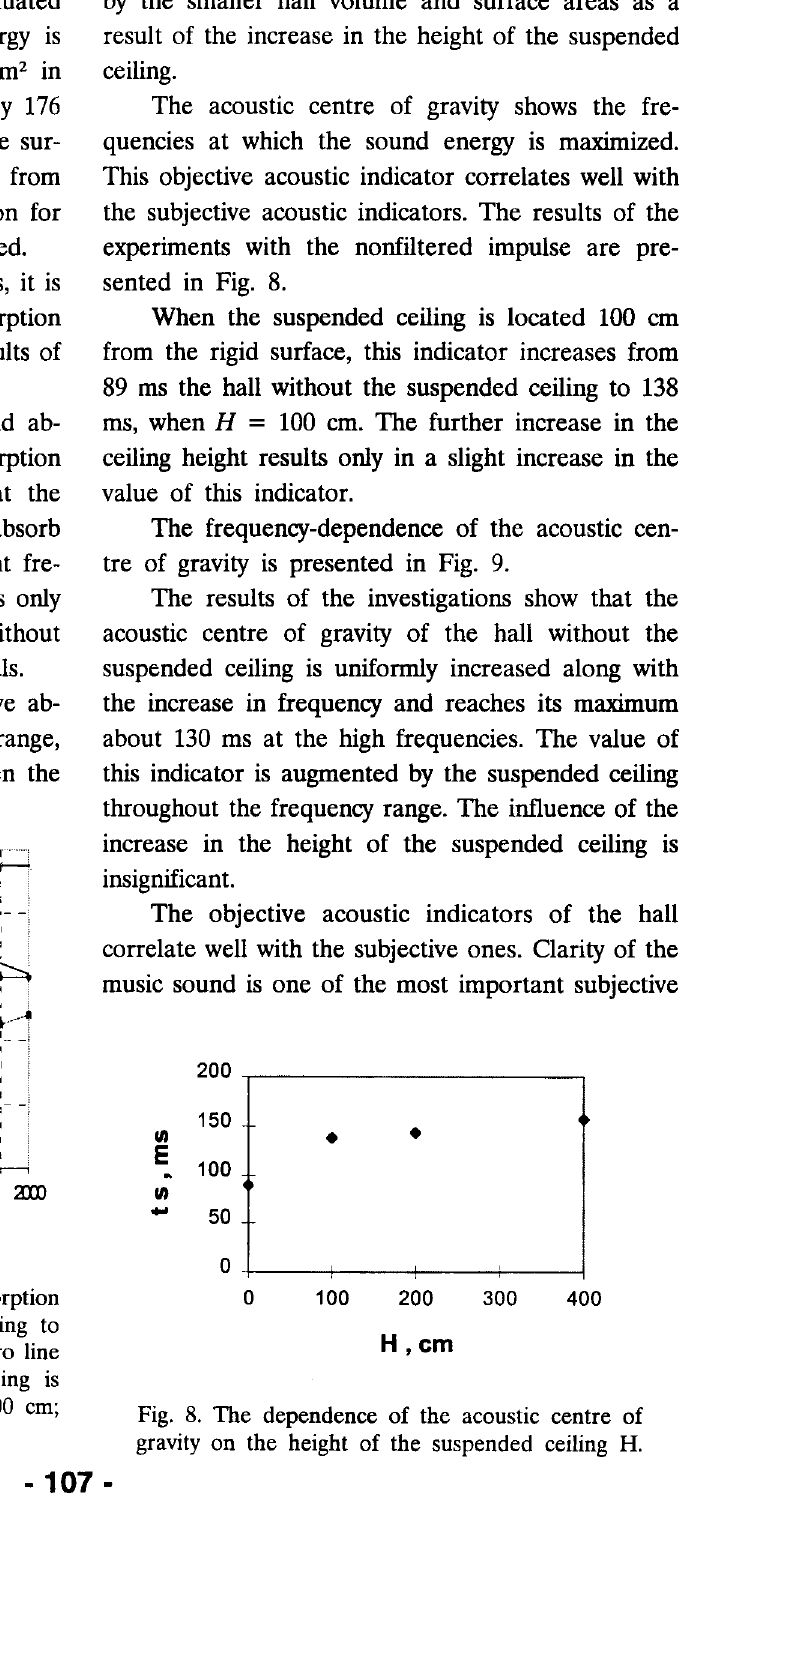
Fig. 7. The relative dependence of the sound absorption on the distance from the resonant suspended ceiling to the rigid ceiling surface. Slit width 100 em. The zero line corresponds to the case when no suspended ceiling is installed. 1 - distance to the rigid surface H = 100 em; 2 - 200 em; 3 - 400 em.